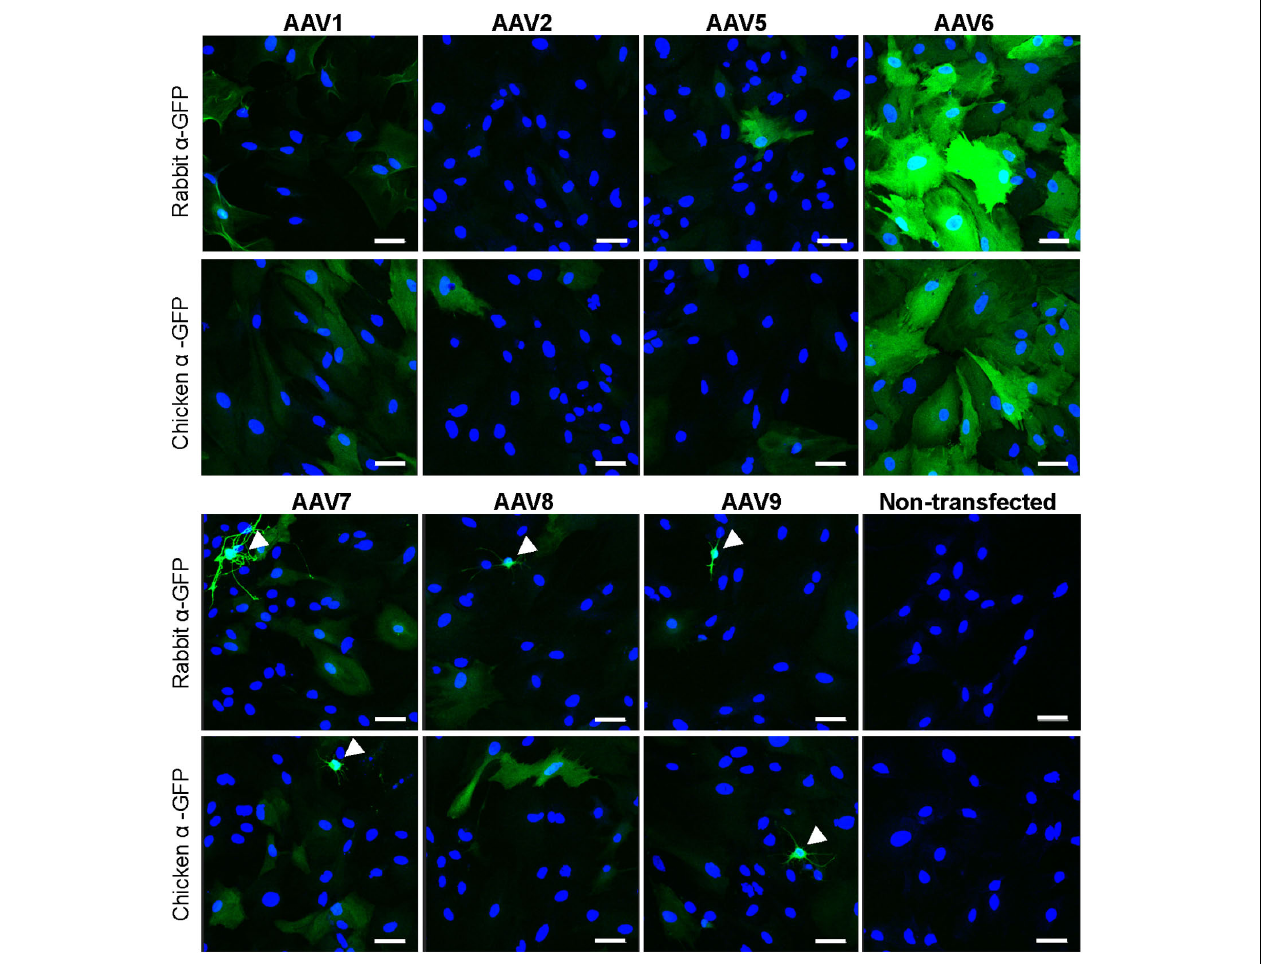
FIGURE 1 | Transduction of primary rat astrocytes with seven different rAAV-green fluorescent protein (GFP) viruses. Astrocytes were transduced with 10 5 gc/cell of either rAAV1, rAAV2, rAAV5, rAAV6, rAAV7, rAAV8, or rAAV9, or treated identically without the addition of virus (non-transfected), for 48 h. Results for rAAV1, rAAV2, rAAV5, and rAAV6 are shown in the top two rows and results for rAAV7, rAAV8, rAAV9 and non-transfected astrocytes are shown in the bottom two rows. Cells were stained with either rabbit or chicken anti-GFP antibodies, as indicated, and counterstained with 4 (cid:48) ,6-diamidino-2-phenylindole dihydrochloride (DAPI) to visualize GFP-negative cells. Images were acquired using a confocal Zeiss LSM510 META microscope at 250 × magnification, in the same cell preparation with identical exposure settings. Scale bar = 50 µ m. Arrowheads point to cells with non-astrocytic morphology that were transduced with rAAV. Results are representative of at least nine wells and four independent experiments per transduction